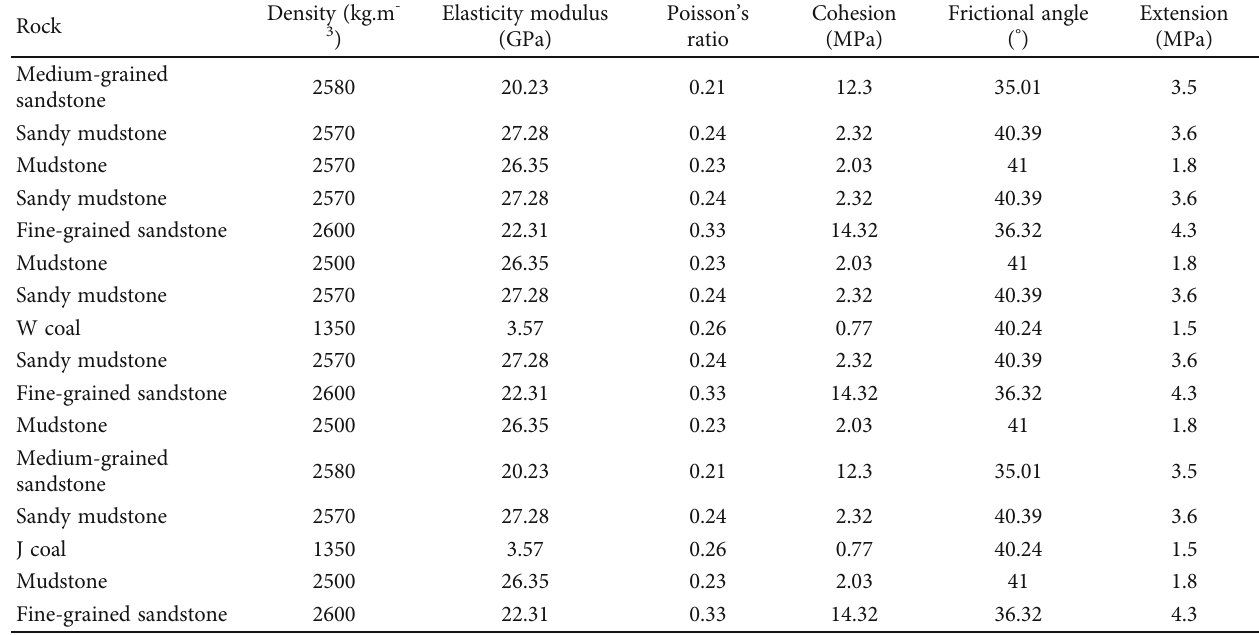
Figure 16: Computational diagrams of (a) the 3D model and (b) coal seam excavation. Table 3: Rock distribution and physical